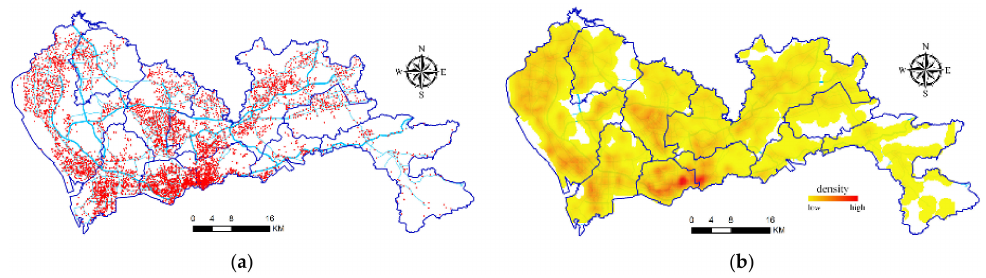
Figure 3. Spatial distribution of mobile phone positioning data: ( a ) 5349 cell towers in Shenzhen; ( b ) 245 million mobile phone positioning